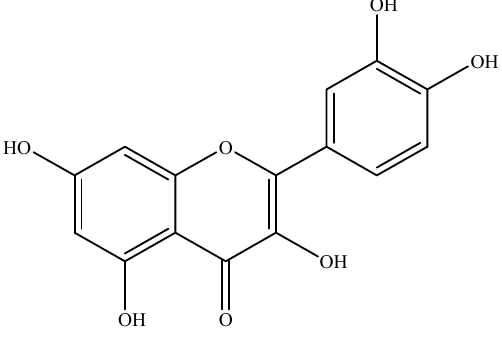
Figure 3. Molecule structure of quercetin. Table1. Identificationofthehoneycombwasteextractsusingliquidchromatography-massspectrometry